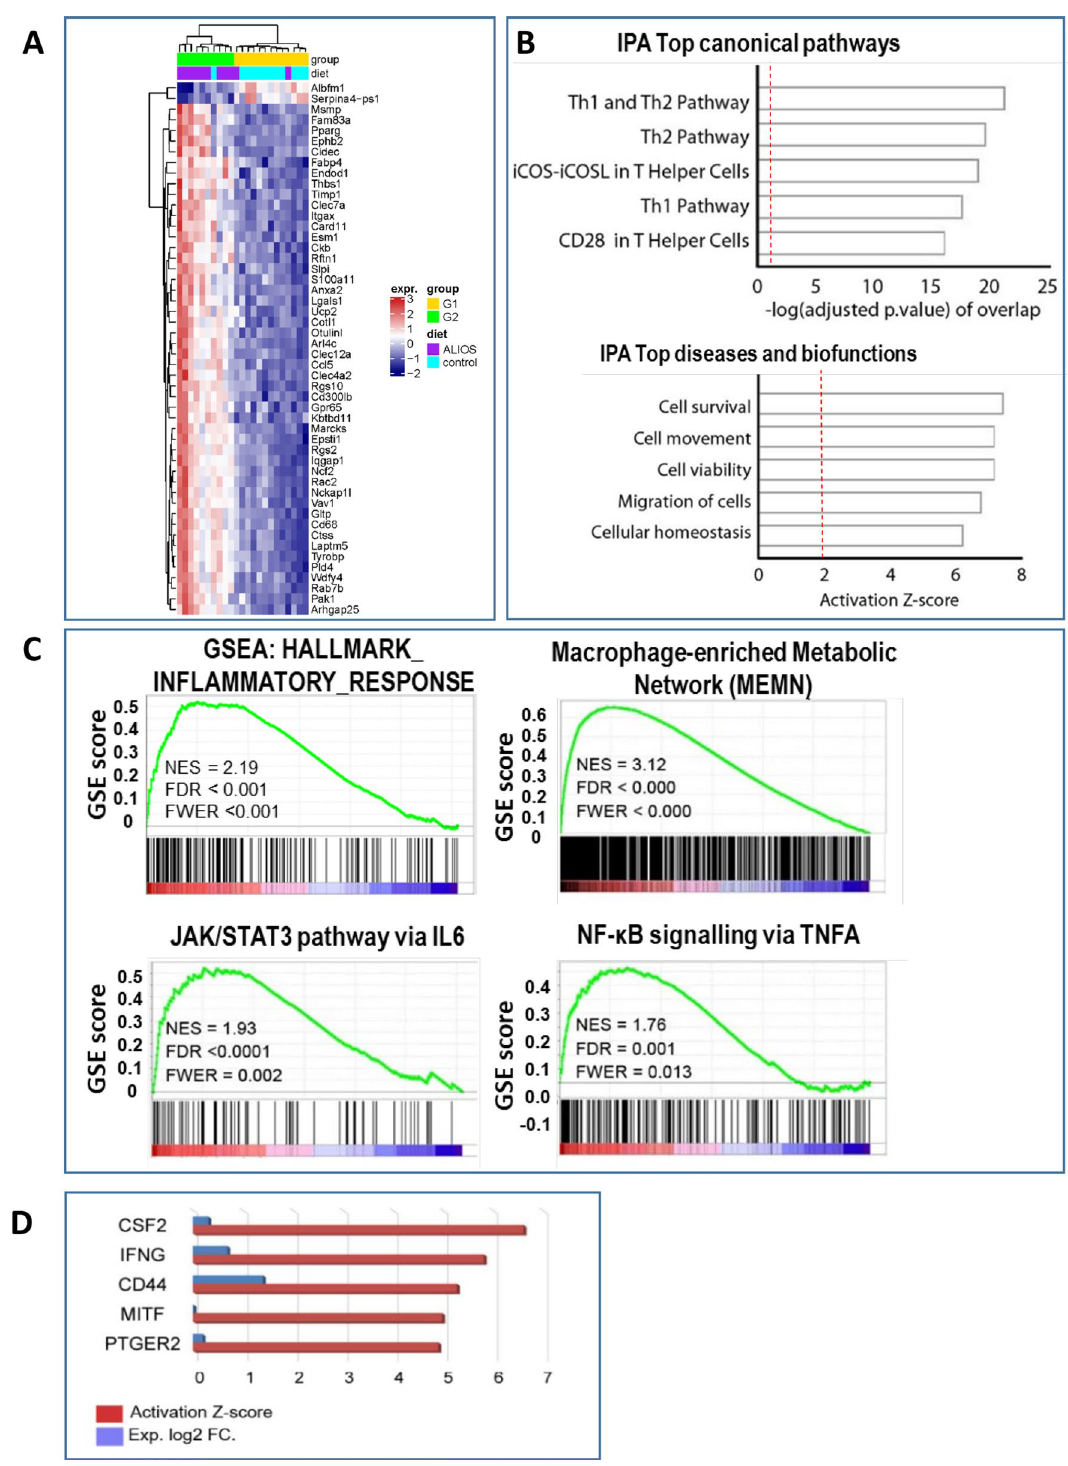
Figure 6. DINAH model transcriptome in NAFLD non-tumour identifies inflammatory pathways, macrophages and CD44 associated with HCC development. The RNA-seq transcriptome heat map, generated after unsupervised clustering analysis of non-tumour (NT) C3H/He, compares the two distinct groups identified ( A ), where G2 distinguished mice bearing greater number and size of tumours. Ingenuity pathway analysis (IPA) of the differentially expressed (DE) genes identified top canonical pathways ranked according to the-log adjusted p-value, or top diseases and bio-functions activation score ( B ). Gene Set Enrichment Analysis (GSEA) highlighted and inflammatory response signatures, the Macrophage enriched metabolic network, NF- κ B and JAK/STAT3 pathways ( C ) as enriched in G2 mice. Considering the top IPA upstream regulators of the non-tumour G2-G1 transcriptomic profile, CD44 was ranked third among activated regulators (red) and was the one with the highest differential expression (DE) (blue) ( D ). Key: NES— normalised enrichment score; FDR—false discovery rate adjusted value; FWER—family-wise error